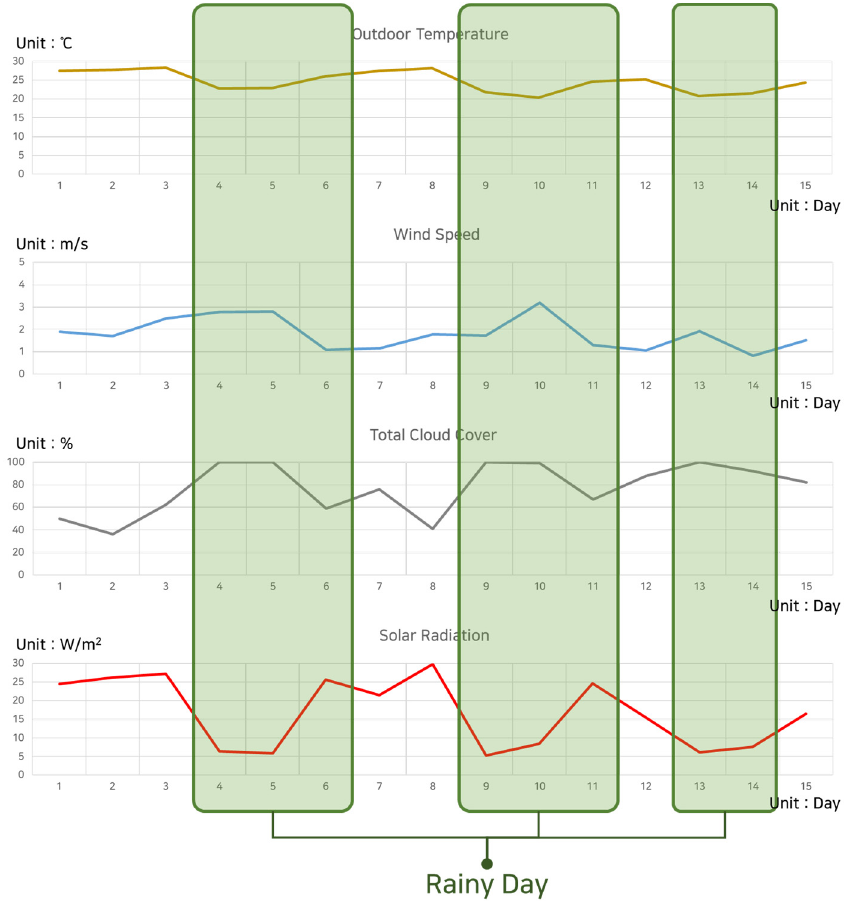
Figure 6. Weather conditions in summer season.